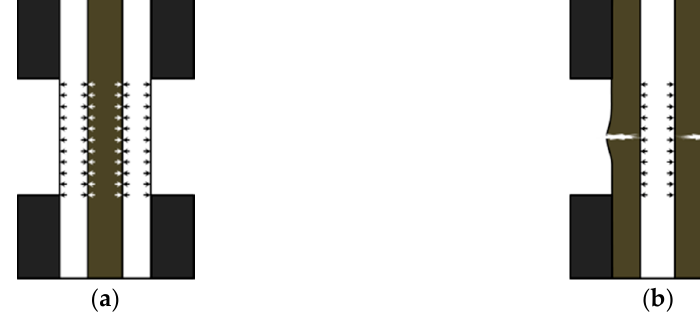
Figure 5. Internal stress diagram with ( a ) Carbon fiber inside, and ( b ) Carbon fiber outside under compression.